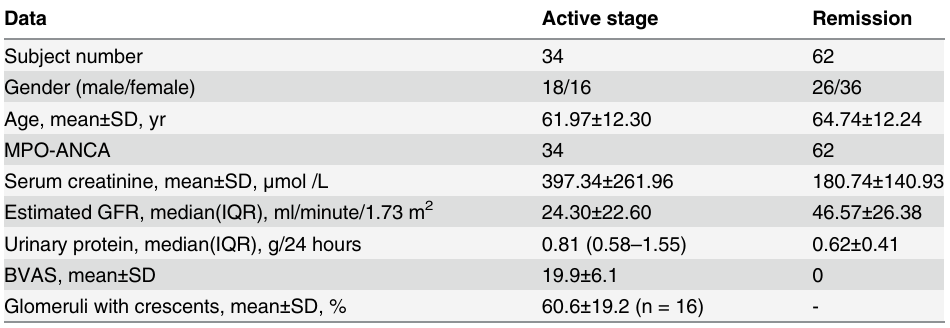
Table 1. General data of patients with AAV *